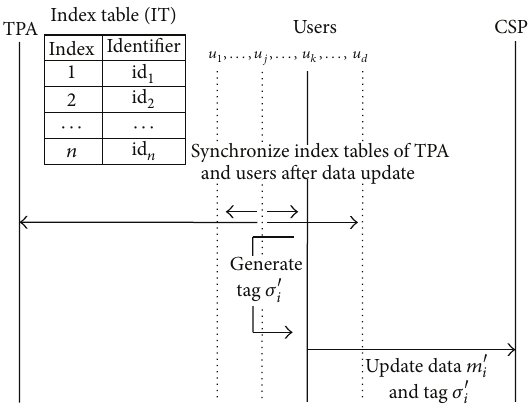
Figure 3: Data update flows when the TPA and users manage an index table